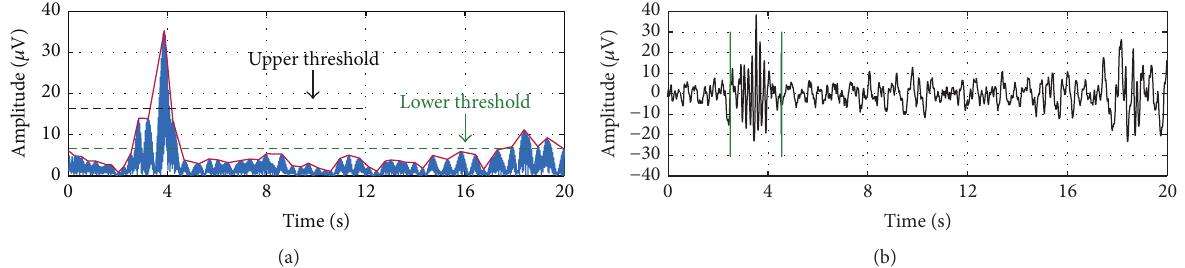
Figure 1: Sample spindle detection envelope (with upper and lower thresholds labeled) and raw signal. (a) Resampled (128Hz), band pass- filtered (10–16Hz), and rectified EEG signal. (b) Raw EEG signal with detected sleep spindle in non-rapid eye movement sleep.